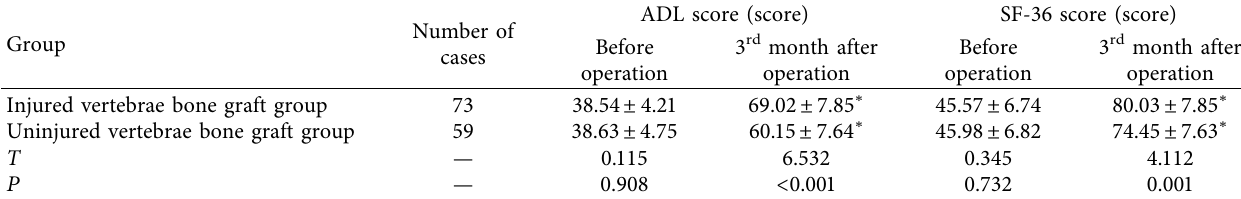
Table 5: Comparison of self-care ability and quality of life between the two groups of patients ( P > 0 . 05) ( X ± S